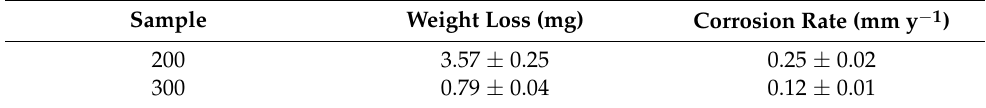
Table 3. Weight loss and corrosion rate of the steels after 24 h of immersion